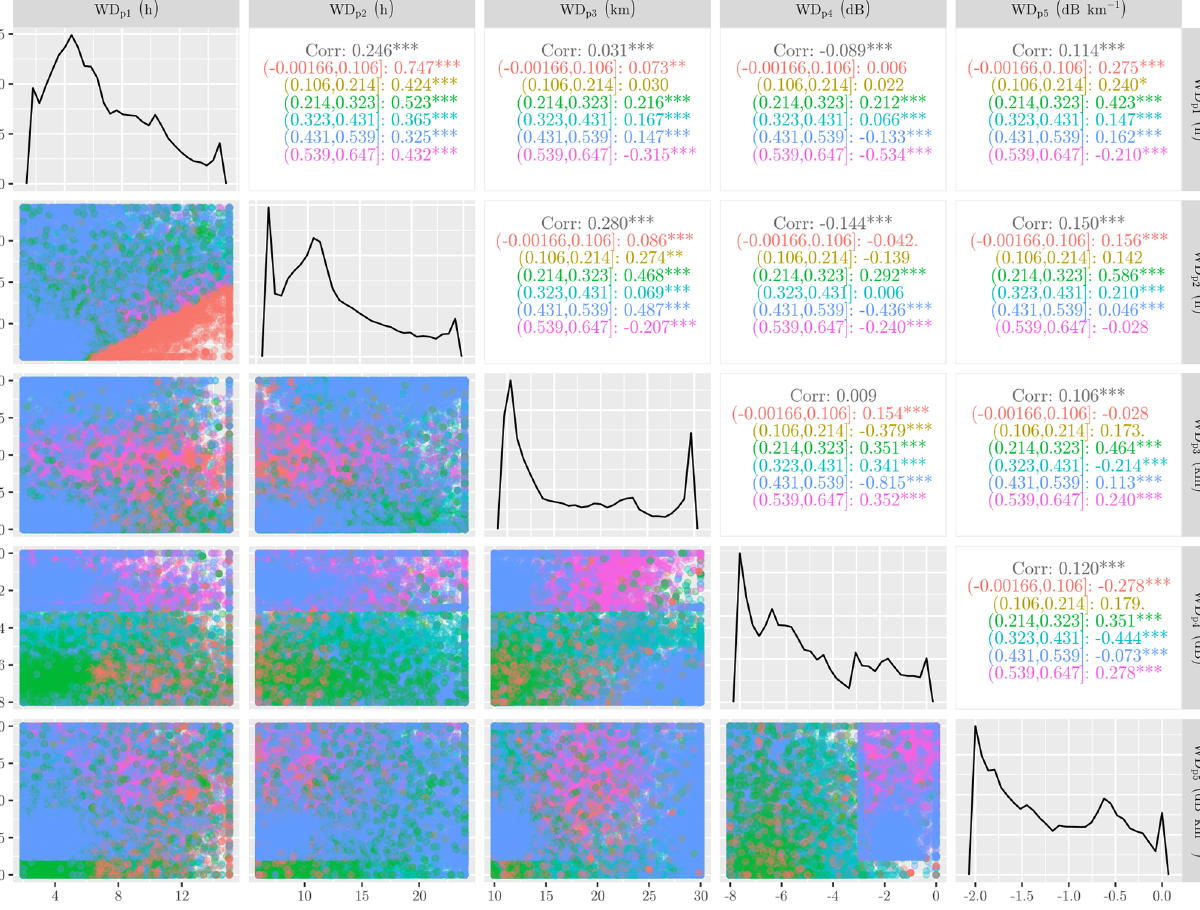
Figure 2. Calibration of the wet–dry classification parameters: panel showing the interaction between calibration parameters at different Matthews correlation coefficient (MCC) values. Note: the upper-right diagonal represents the correlation among the parameters for both the total samples (black values) and the grouped samples (color values) by MCC intervals. Significance levels: ∗∗∗ p < 0 . 001, ∗ p < 0 . 05, “.” p < 0 . 1, and no symbol p < 1.